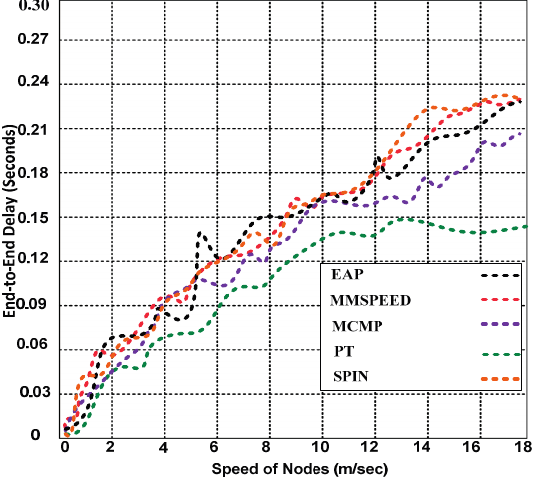
Figure 9. End-to-end delay for PT, SPIN, MCMP, MMSPEED and